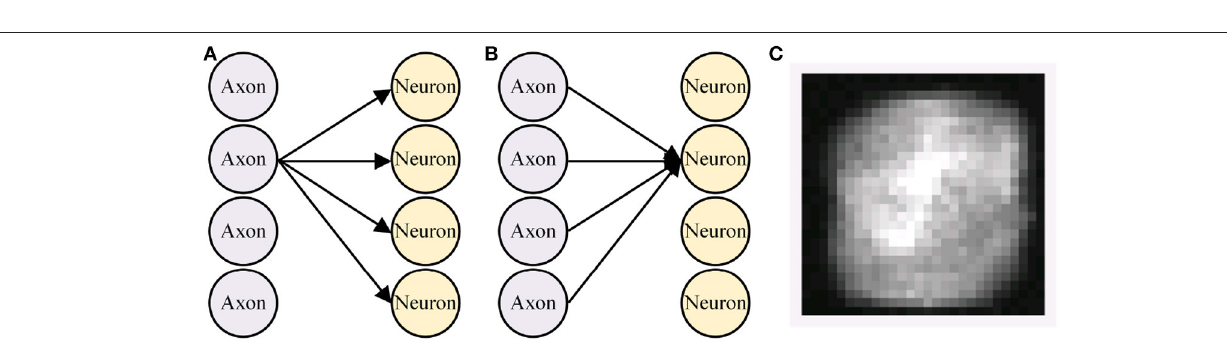
FIGURE 4 | Definition of (A) pre-group and (B) post-group, and (C) average of each pre-group synapses’ absolute